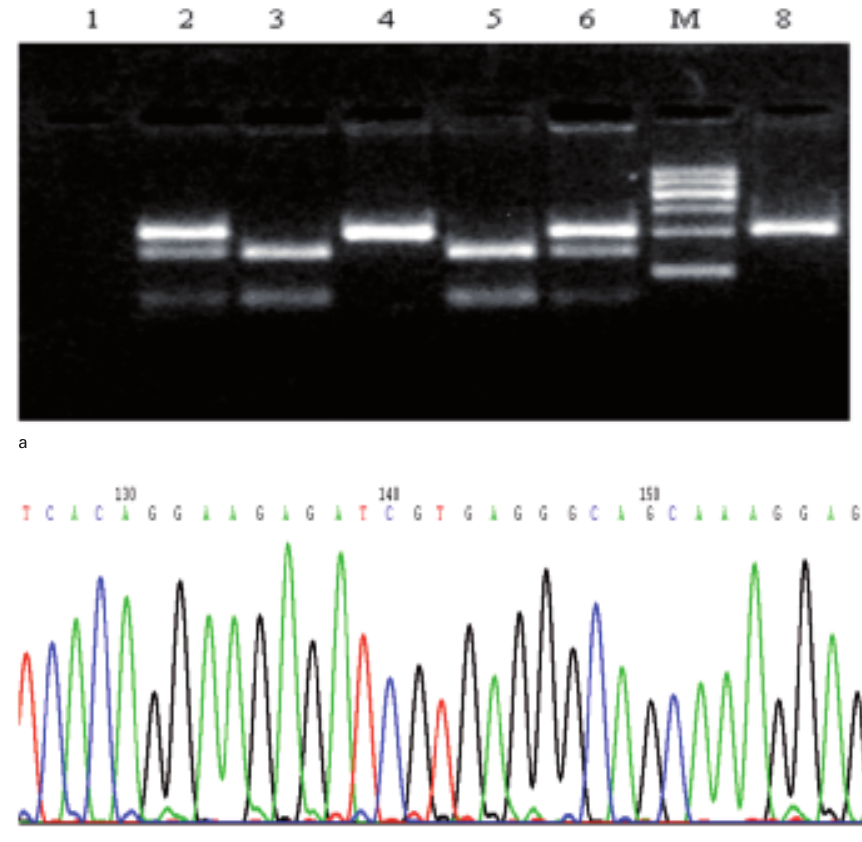
Figure 1 a Electrophoresis patterns for MDR1 genotypes by PCR- RFLP based assay. Lane M: 100 bp DNA Marker; lane 8: uncut; lane 2, 6: heterozy- gous CTgenotype; lane 4: homozygous T allele; lane 3, 5: ho- mozygous C alleles; lane 1: control (water). b Direct sequencing results for the CC genotype. No140 is the 3435C>T